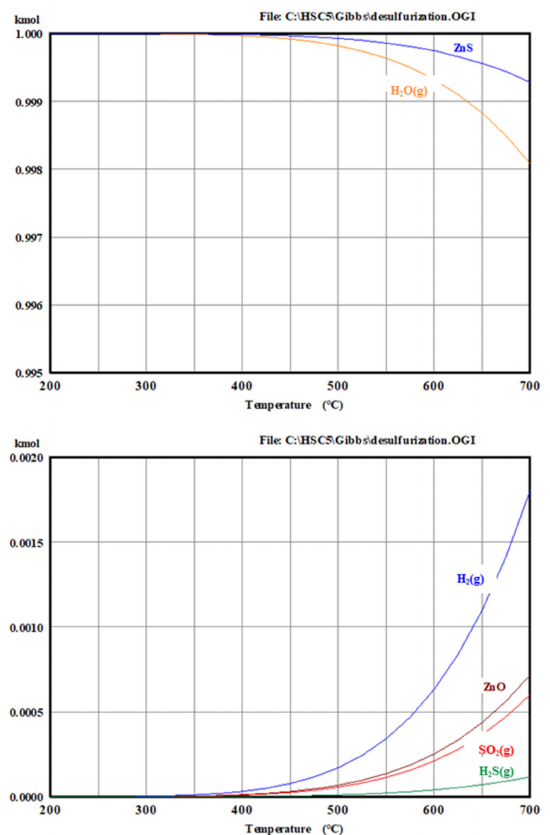
Figure 5. Effect of temperature on the consumption of reactant and generation of products in regeneration by H 2 O, using Outukumpu HSC 5.1